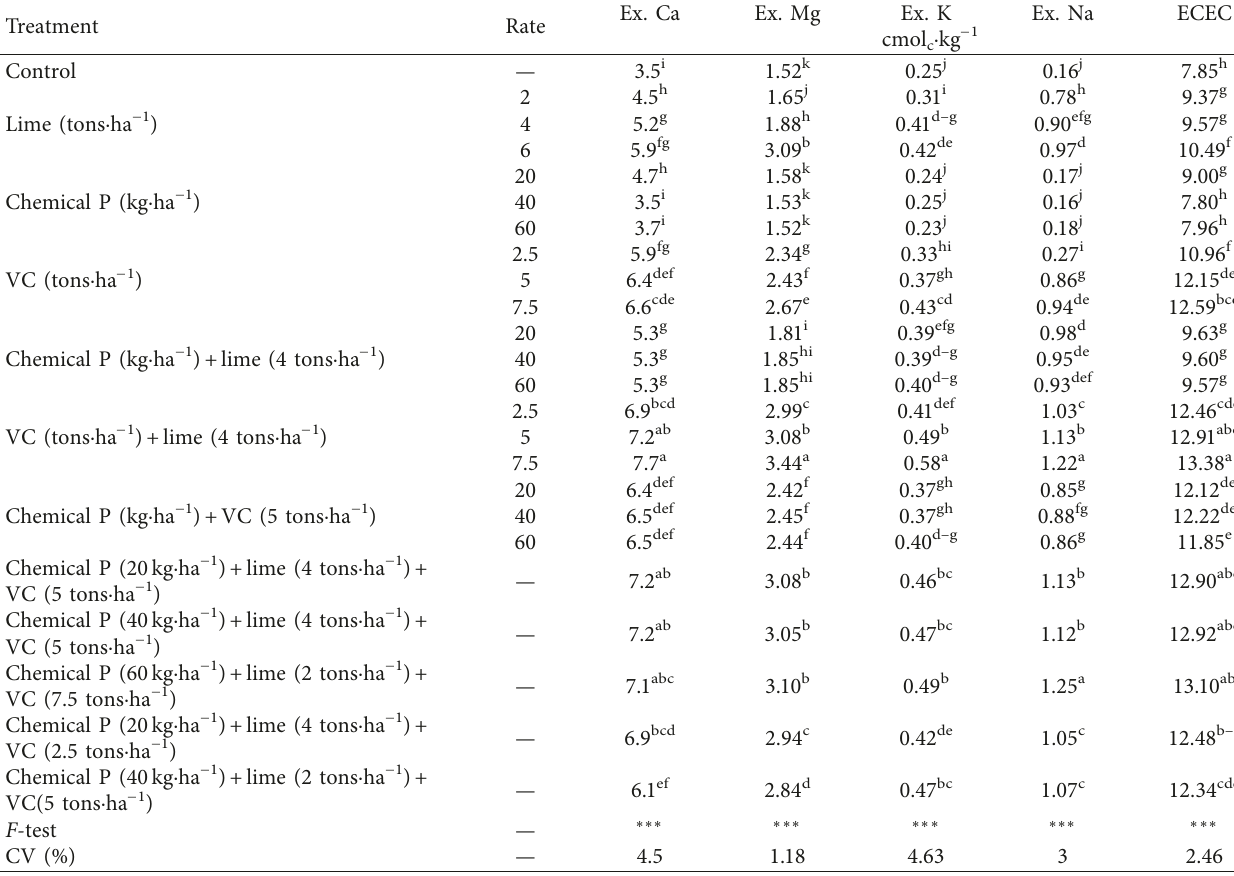
Table 6: Effects of treatments on exchangeable bases and effective cation exchange